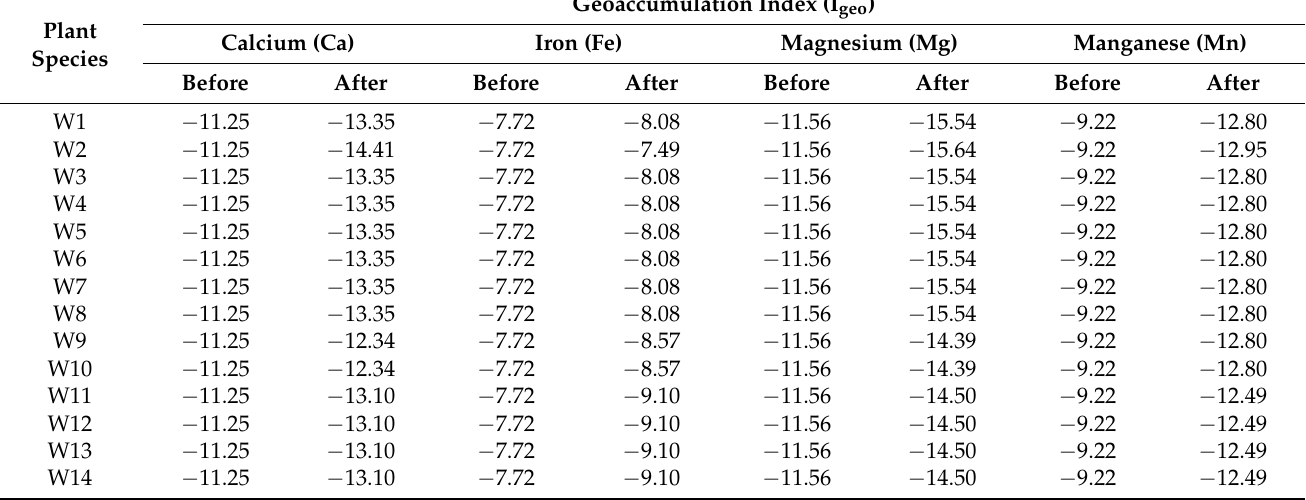
Table 6. Geoaccumulation index (I geo ) for soil before and after the phytoremediation of domestic sewage with various tropical plant